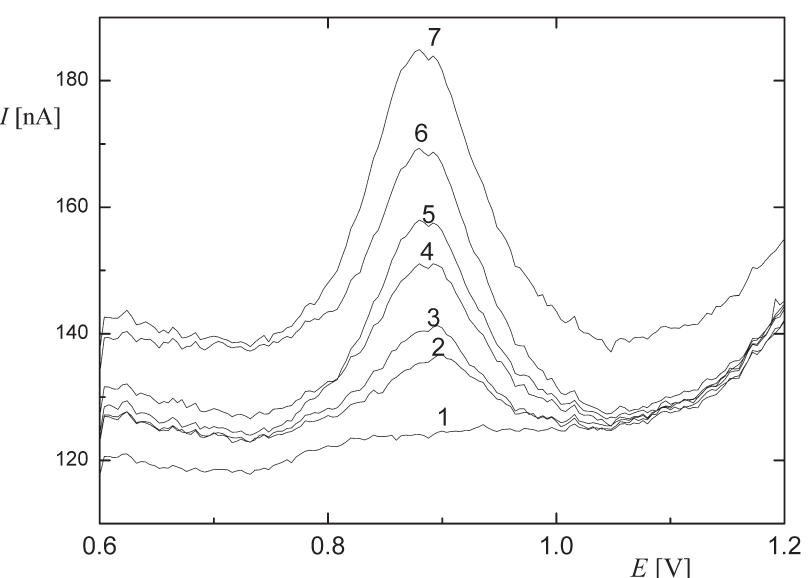
Figure 3. DP voltammograms of metoclopramide (0 (1); 1 (2); 2 (3); 4 (4); 6 (5); 8 (6); 10 (7) µmol L –1 ) measured on BDDFE in BR buffer pH 6.